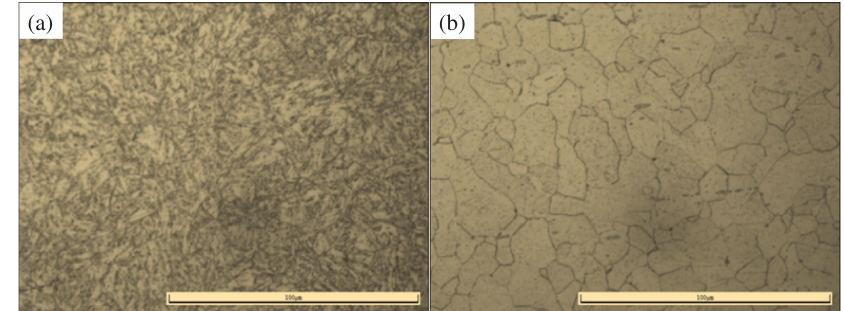
Figure 2: Microstructures of the base materials (a) T92 (b) Super